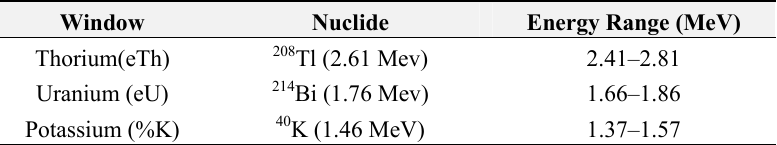
Table 1. Spectral energy ranges of the airborne radiometric